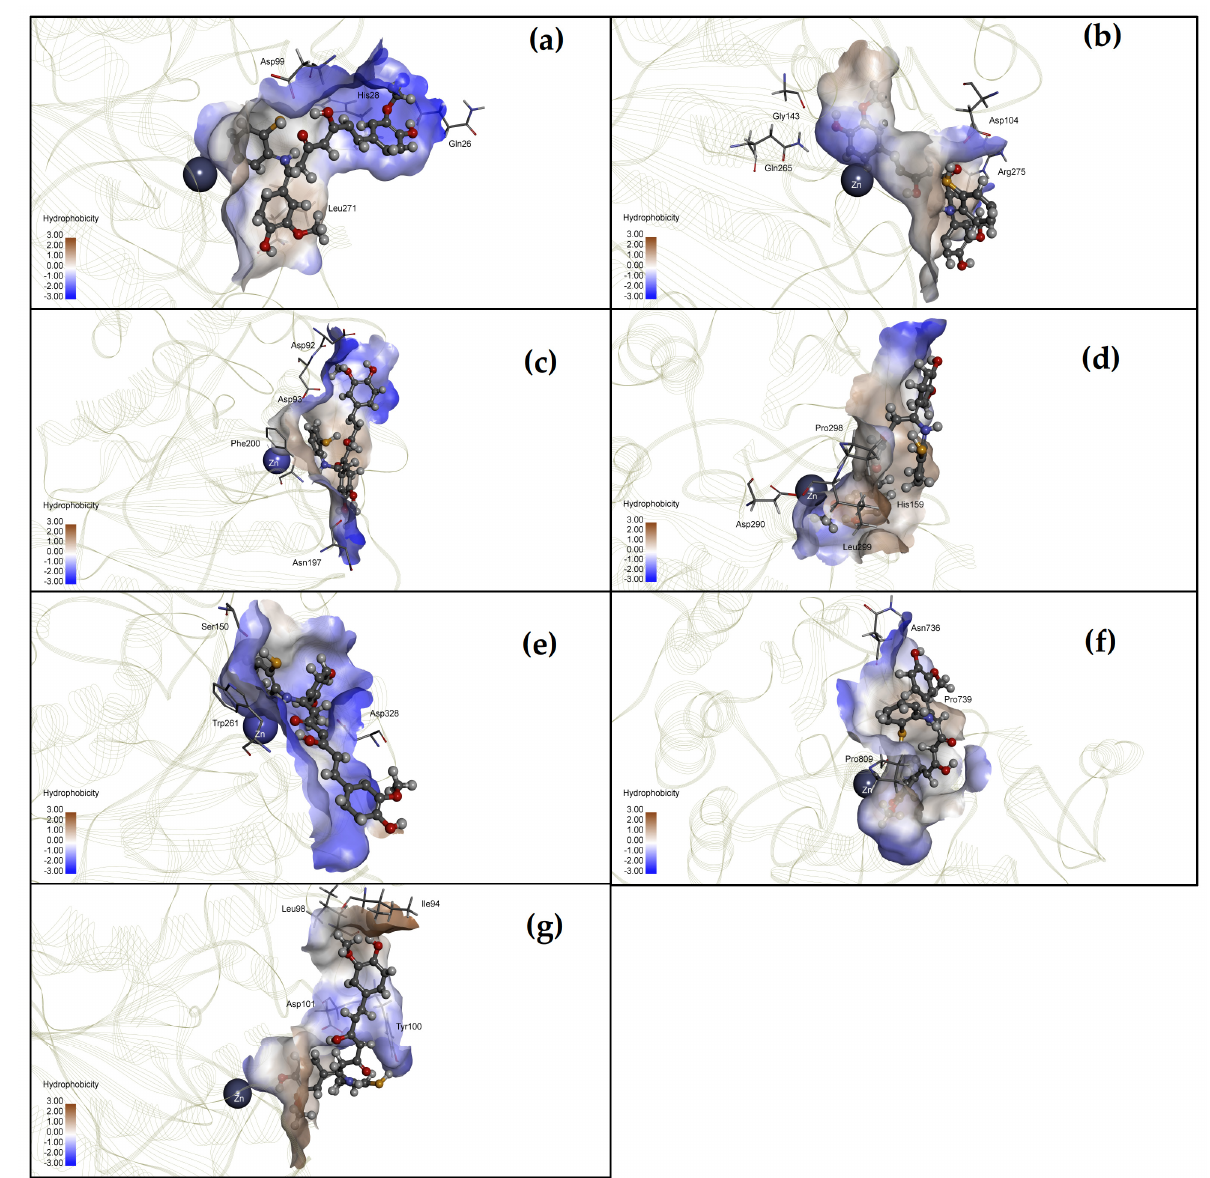
Figure 3. The interaction between CU17 and the active site of ( a ) HDAC1, ( b ) HDAC2, ( c ) HDAC3, ( d ) HDAC4, ( e ) HDAC6, ( f ) HDAC7, and ( g ) HDAC8.